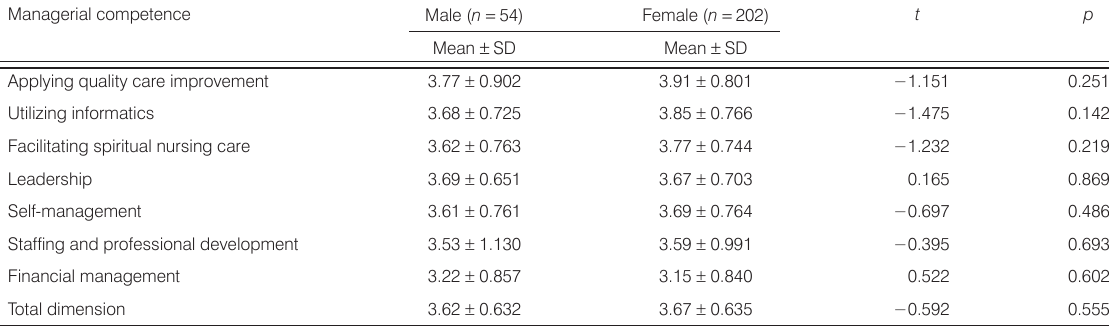
Managerial competence